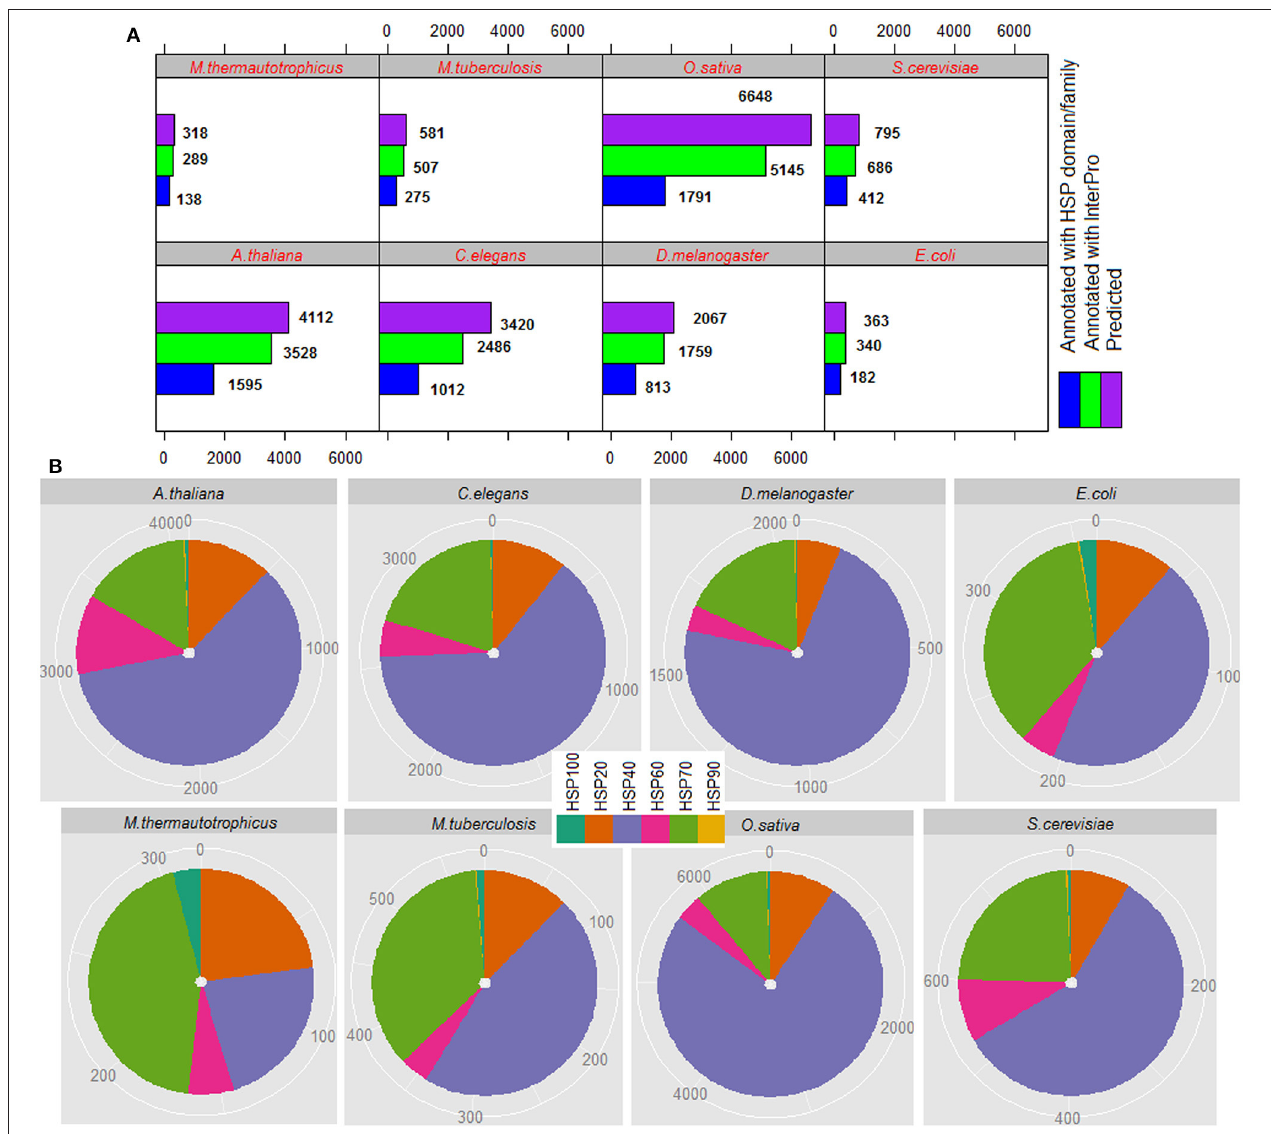
FIGURE 5 | (A) Proteome-wide prediction of HSPs for eight different species, by using the proposed approach. It can be seen that ∼ 50% of the predicted HSPs are annotated with InterPro HSP family/domain. (B) Family-wise distribution of predicted HSPs, where it is seen that > 50% HSPs are predicted with HSP40 and < 1% with